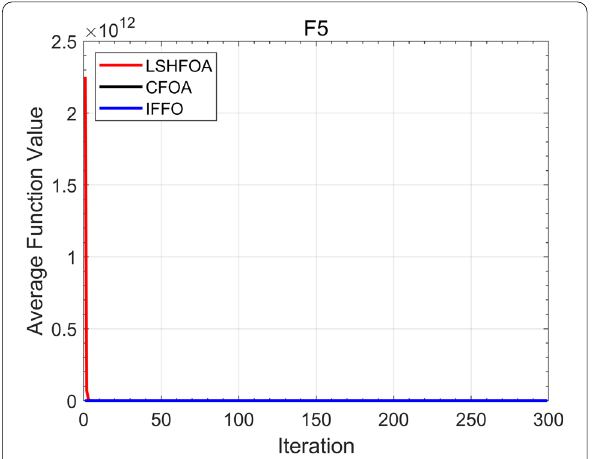
Fig. 11 Performance of the algorithm under F5 function